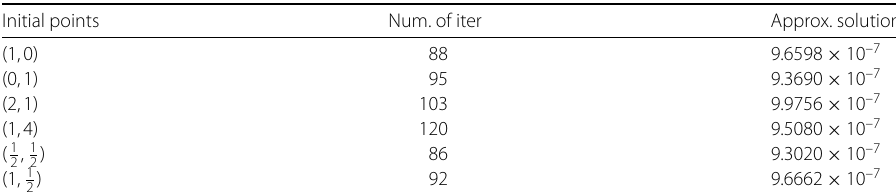
Figure 1 Convergence of the sequence { v n } with